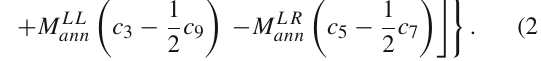
Fig. 3 Plot of sin δ as a function of parameter values of CKM matrix elements for the decay channel of ¯ B 0 → π + π − π 0 s